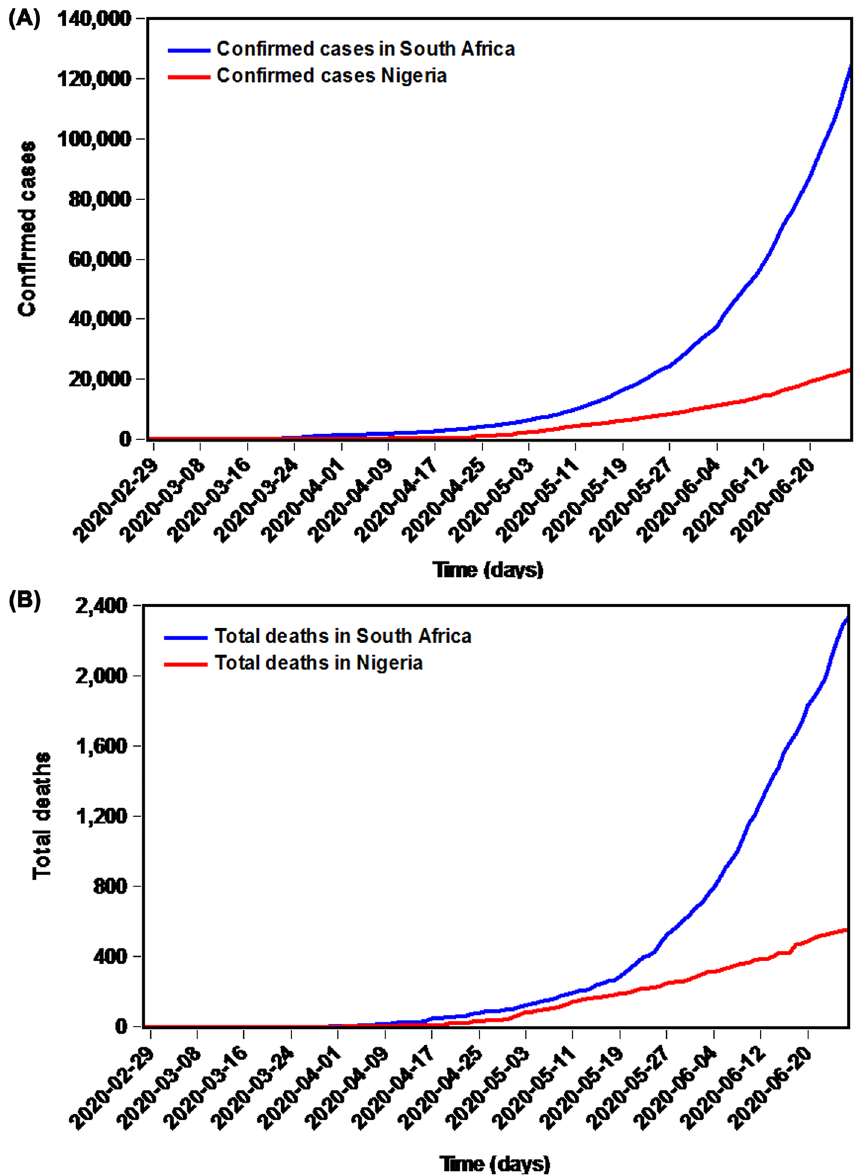
Figure 2. Time series plots showing the prevalence and mortality data of COVID-19 in South Africa and Nigeria ( A ) The overall confirmed cases in these two countries; ( B ) The overall deaths in these two